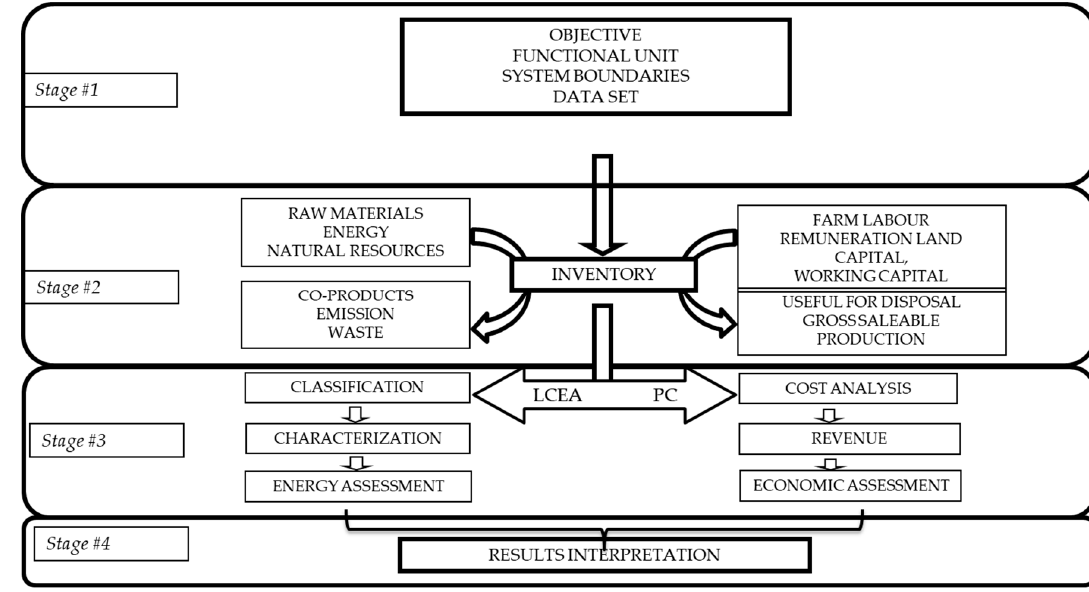
Figure 3. Methodological implementation .